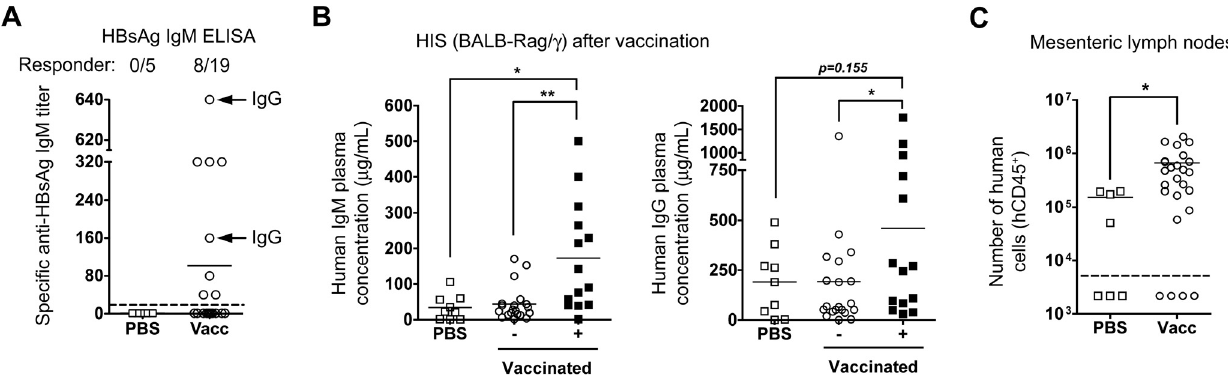
Figure 2. Vaccination of HIS mice. (A) The graph shows the titers of HBsAg-specific IgM measured by ELISA in PBS-injected and HBsAg-vaccinated HIS mice, 10 days after the third i.m. injection. Vaccinated mice are designated as responder animals when antigen-specific antibody titers are above the cut-off value (doted horizontal line). Responder animals with a detectable antigen-specific IgG response are indicated by the horizontal arrows. (B) The graphs show the concentration of total IgM (top graph) and IgG (bottom graph) in the plasma of PBS-injected (open squares) or vaccinated HIS mice (pool of HBsAg- and TT-vaccinated) at the end of the vaccination protocol (mean values: horizontal bars). The vaccinated are separated between non-responder (- columns; open circles) and responder ( + columns; closed squares) mice. (C) The graph shows the number of human cells (hCD45 + ) harvested in mLN of PBS-injected vs. vaccinated (TT and HBsAg) HIS mice. The mLN were not detected in 43% of mock-injected mice, as compared to 16% of vaccinated animals (symbols placed under the doted line). The animals without detectable mLN were excluded to calculate the average number of human cells per group (horizontal bar). * p , 0.05; ** p , 0.01. doi:10.1371/journal.pone.0013137.g002 PLoS ONE |